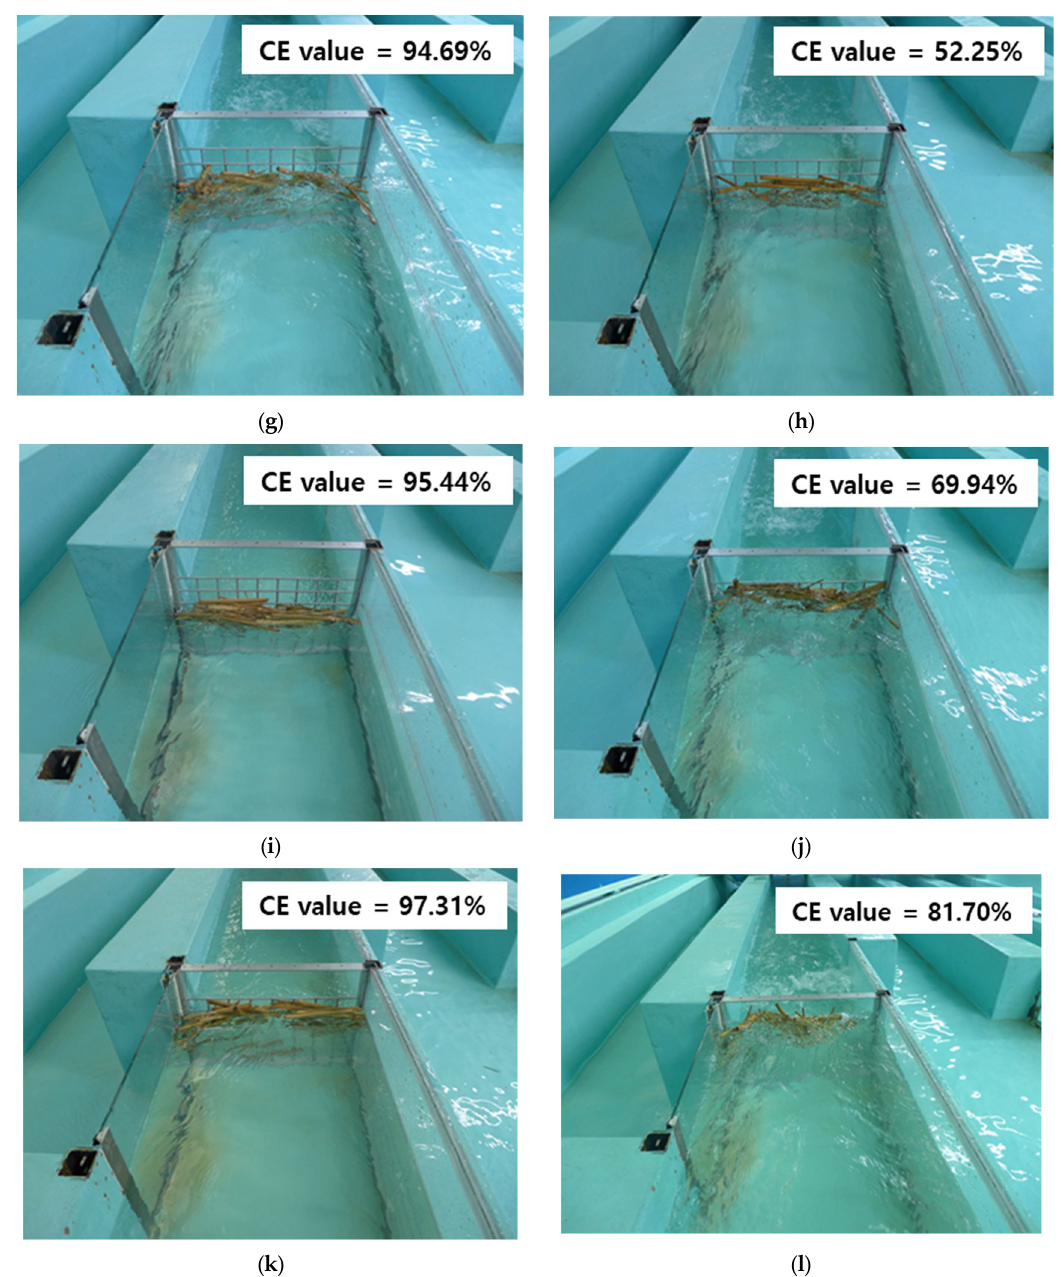
Figure A1. Capture efficiency of the driftwood capture trellis by experimental condition: ( a ) B400mm- H80mm-V0.3; ( b ) B400mm-H80mm-V1.8; ( c ) B400mm-H120mm-V0.3; ( d ) B400mm-H120mm-V1.8; ( e ) B400mm-H160mm-V0.3; ( f ) B400mm-H160mm-V1.8; ( g ) B400mm-H200mm-V0.3; ( h ) B400mm- H200mm-V1.8; ( i ) B400mm-H240mm-V0.3; ( j ) B400mm-H240mm-V1.5; ( k ) B400mm-H280mm-V0.3; ( l ) B400mm-H260mm-V1.2.